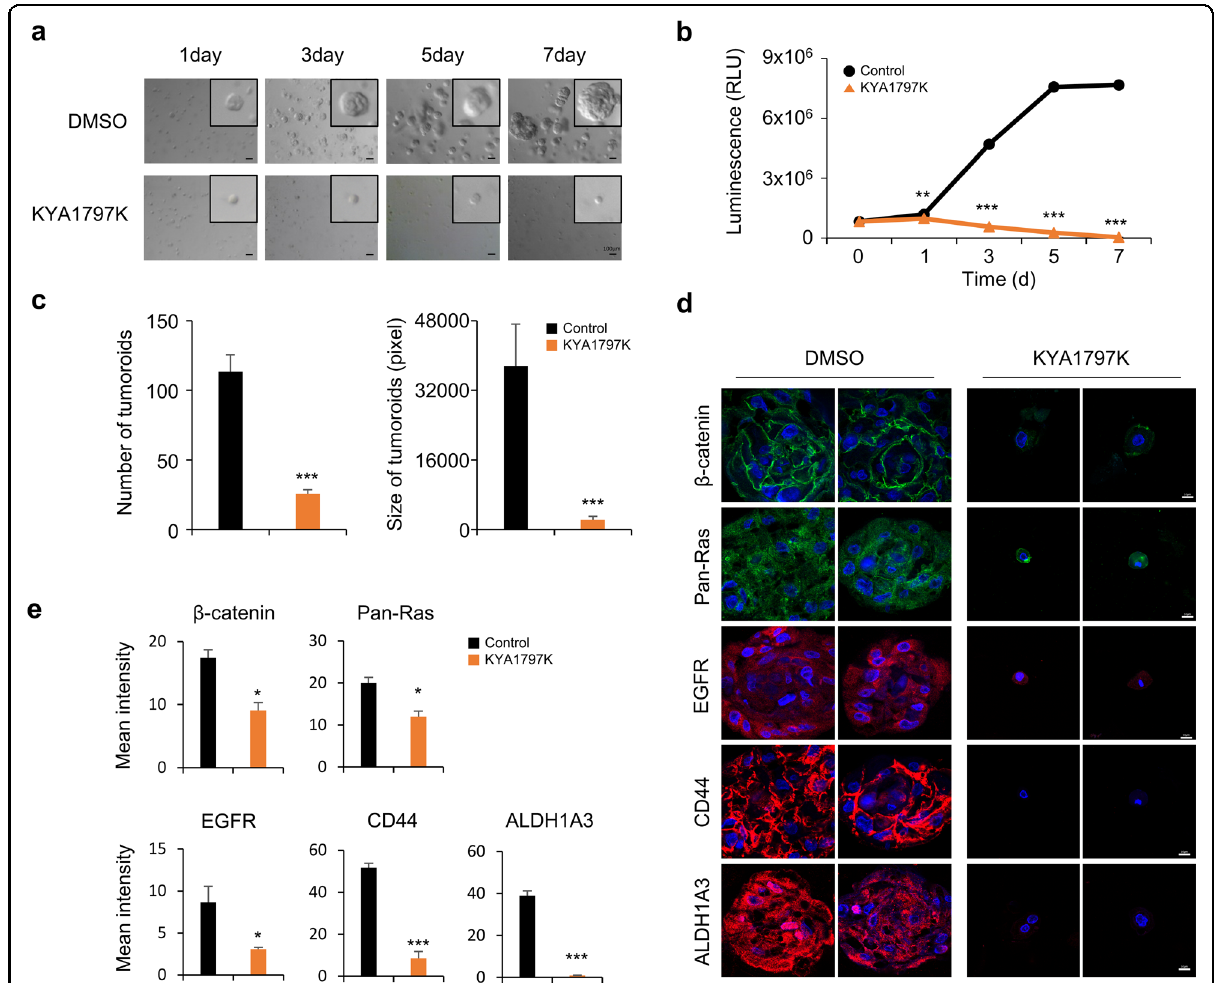
Fig. 4 Effects of KYA1797K on cancer stemness of TNBC cells. TNBC PDCs were cultured using a Matrigel-based 3D culture system described in “ Materials and methods ” . a The effect of KYA1797K (25 μ M) on tumor organoids of TNBC PDCs was tested for 7 days. Representative images